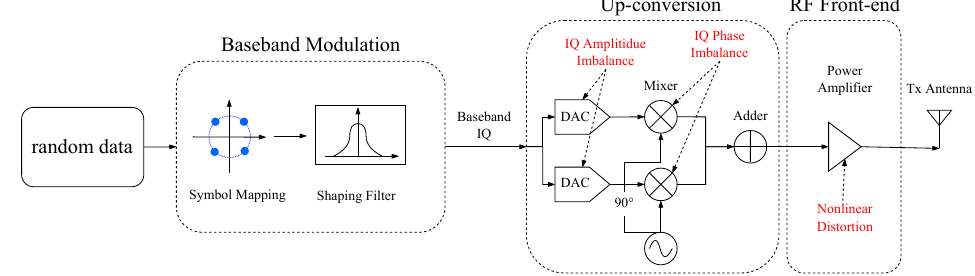
Figure 2. The process of digital modulation and